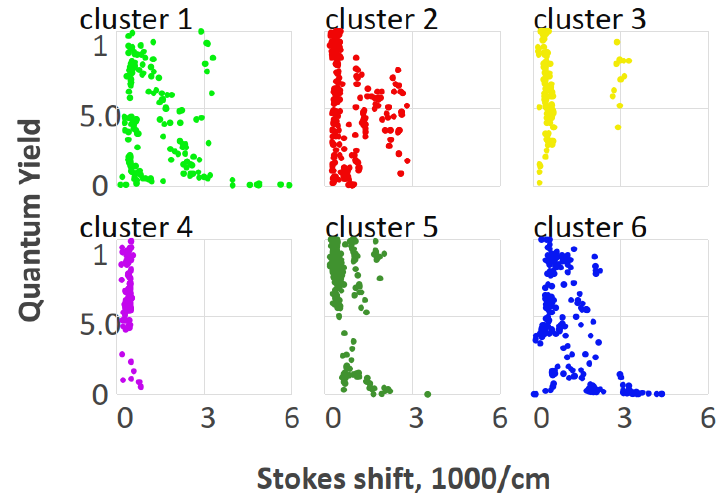
Figure 7. Quantum yield versus Stokes shift diagram for a six-cluster dataset of 115 BODIPYs. For a key for the clusters, see Schemes 1–6.